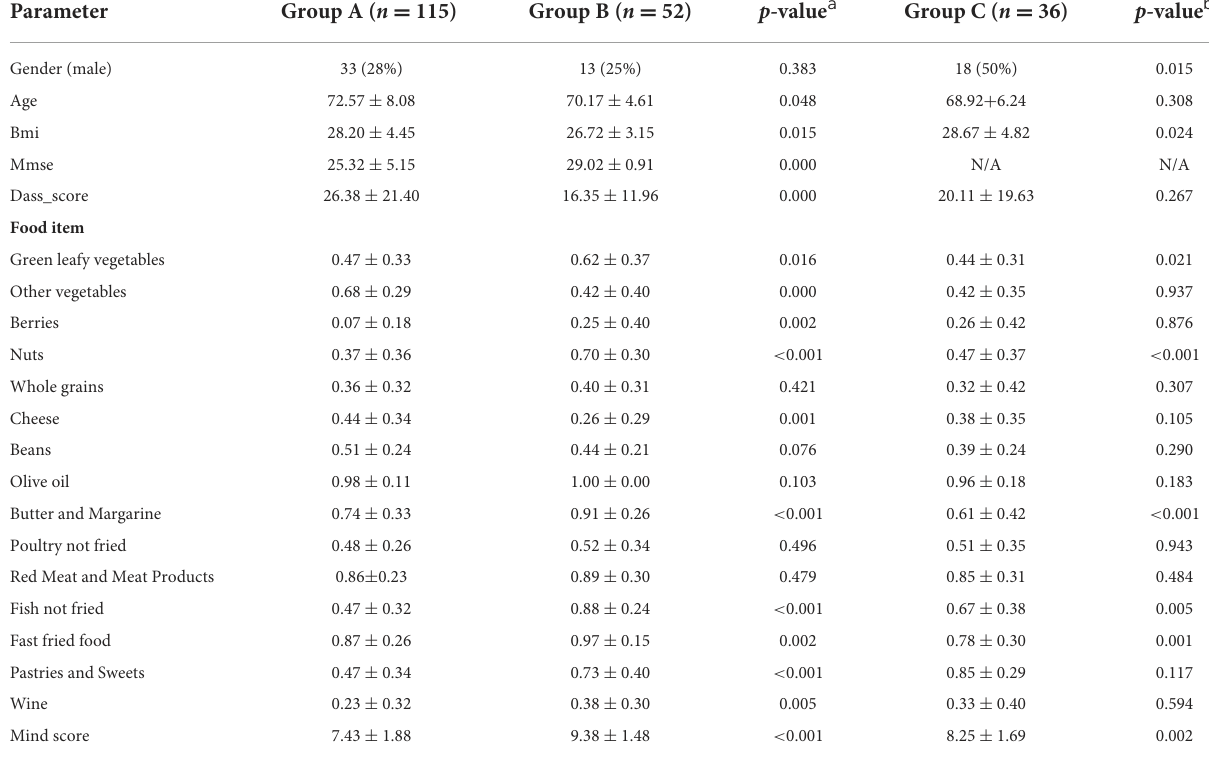
TABLE 1 Comparative presentation of the demographic, anthropometric, clinical characteristics and dietary intake of the study participants. Parameter Group A ( n =